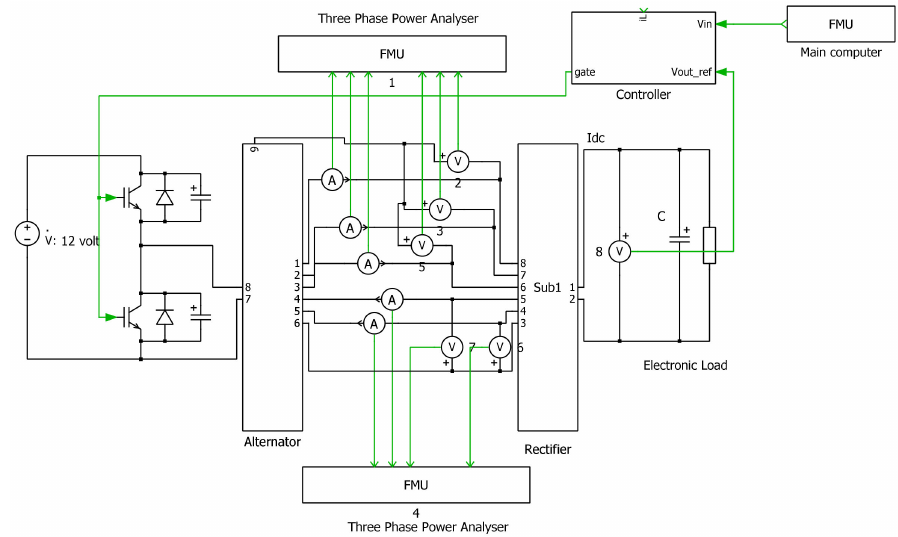
Figure 39. Experimental setup for the controller and alternator/rectifier “Reprinted from [47]”. Power electronic is used again in [48] to produce a dual output voltage for the auto- motive alternator. The authors used SMRs to produce 42-volt and 14-volt outputs from the alternator. A full match for the load is achieved, and the delivered power for the two outputs is performed to any one of the combinations according to the load demand. Results indicated a good response and performance for the proposed combination. Figure 40 illustrates the circuit diagram for the dual output new SMRs.